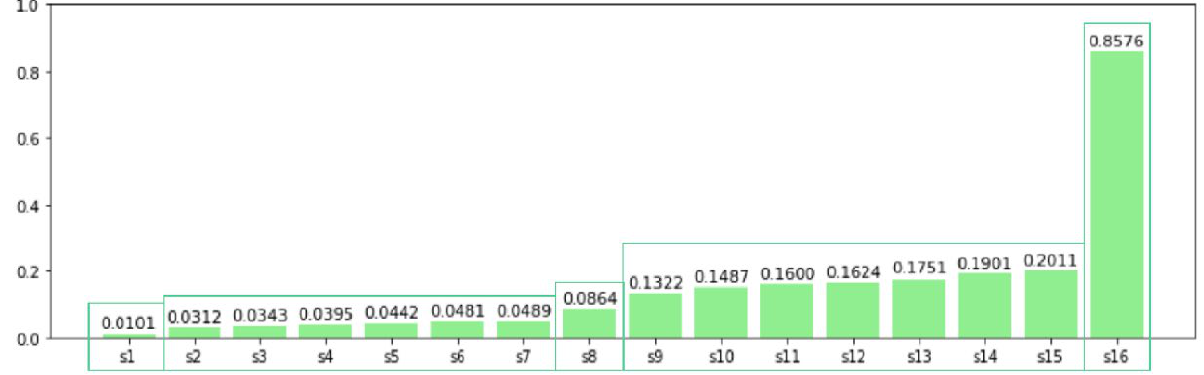
Figure 6. The VMD-SE process of case 2.